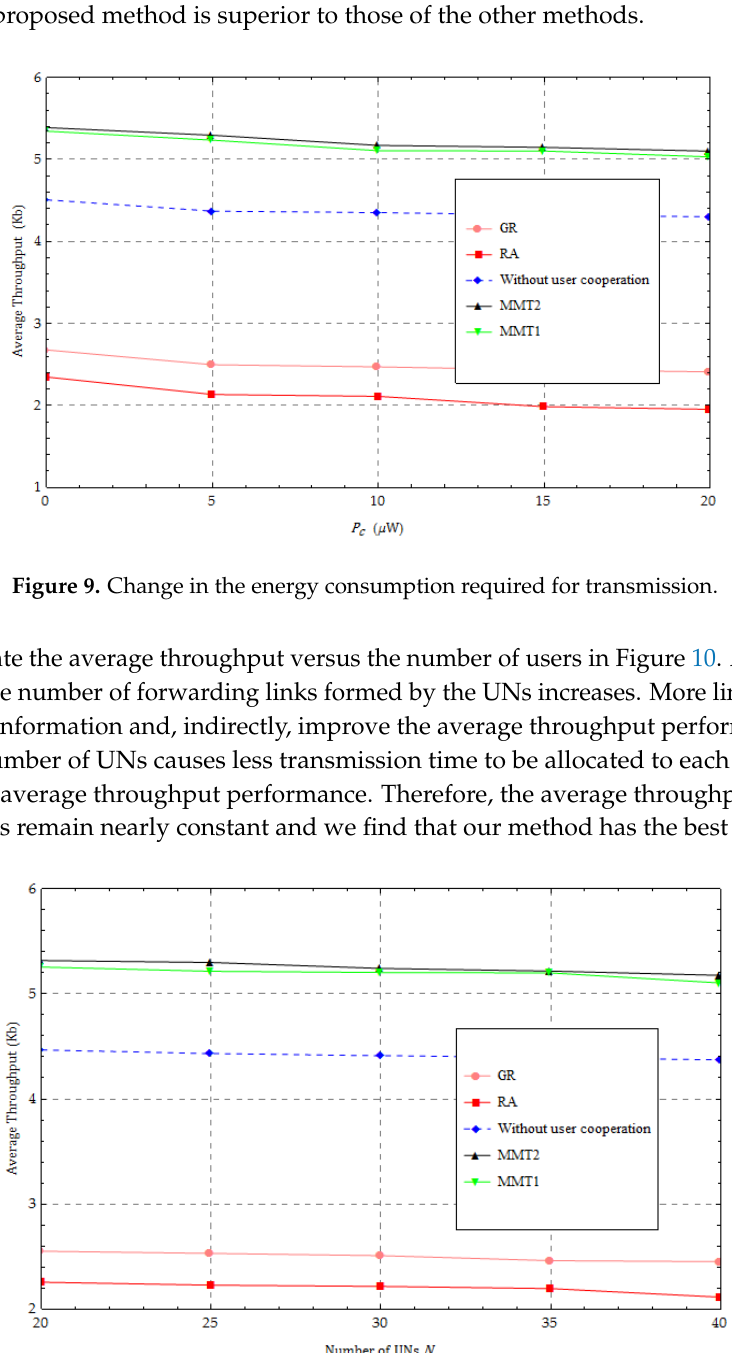
Figure 8. Change in the amount of receiver circuitry.